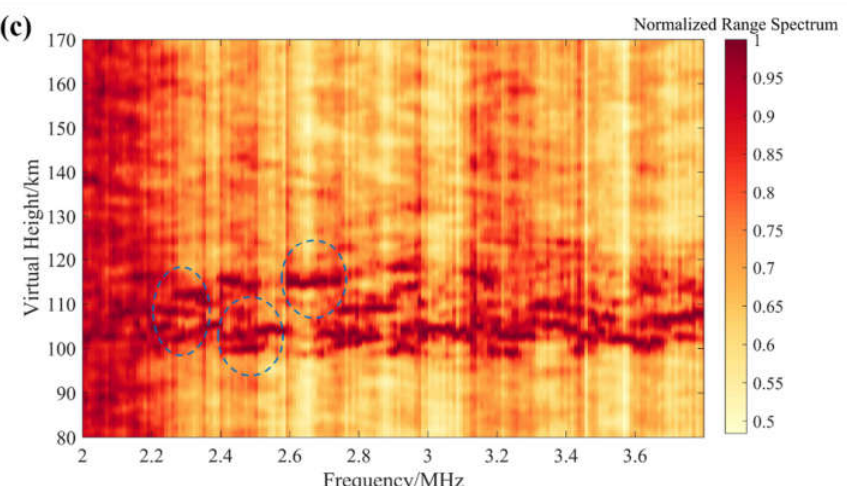
Figure 1. Height–intensity ionogram of the Es layer measured near Wuhan, China at 17:46 LT (UTC+8) on 8 June 2021. ( a ) Conventional ionogram with an intrinsic range resolution of 3.84 km. ( b ) Ionogram showing the normalized energy at different frequencies and altitudes. ( c ) Ionogram with a range resolution of 38.4 m as obtained using the FDI technique.